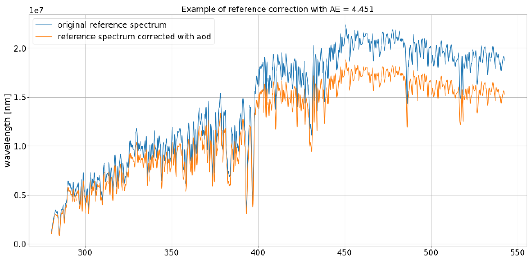
Figure 3 Reference spectrum modified based on aod from Lidar